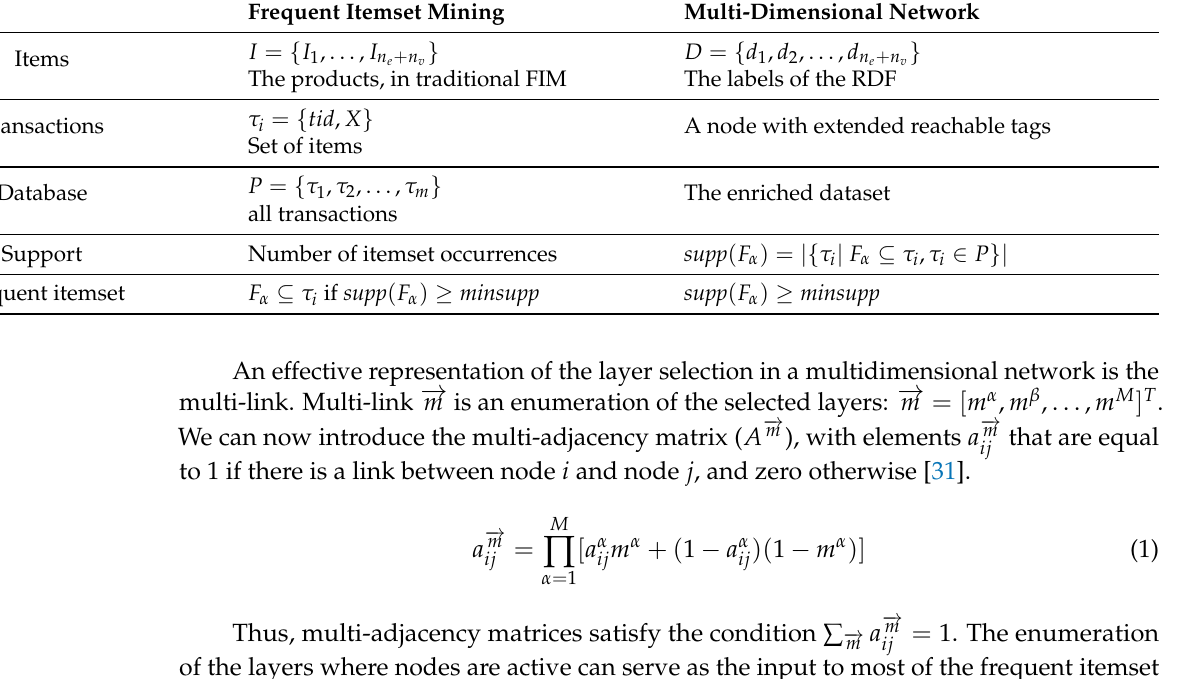
Table 1. Summary of the frequent itemset mining (FIM) technique notation and its multidimensional counterpart. Frequent Itemset Mining Multi-Dimensional